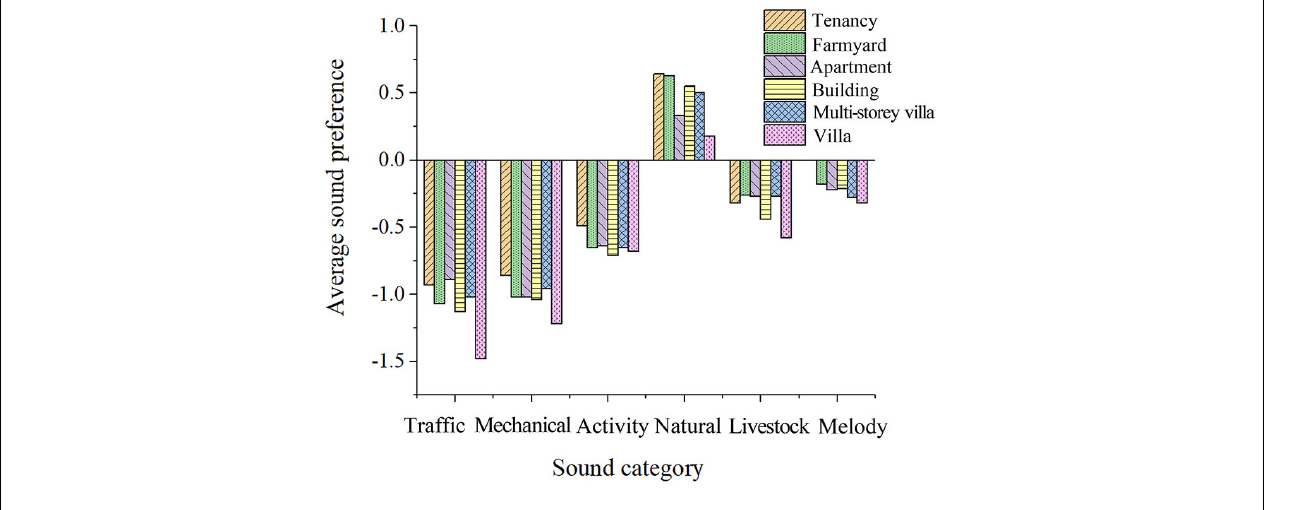
FIGURE 12 | Sound preference of people with varying conditions of